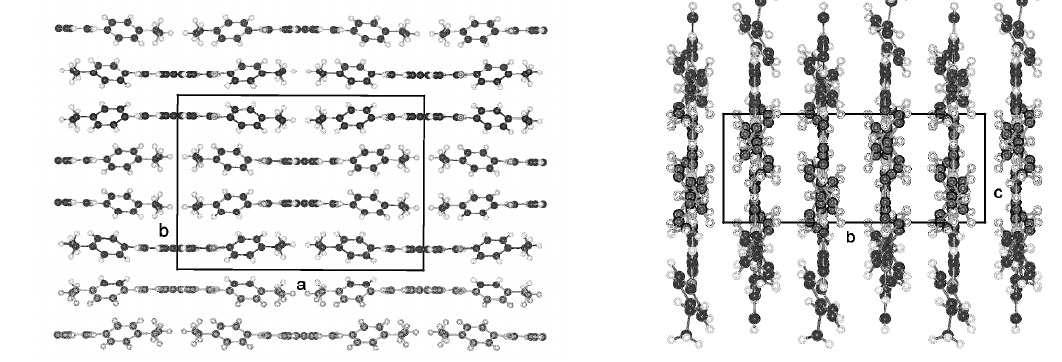
Figure 26. Representation of the packing arrangement of TBAA-2, space group Pbcn, in two projections, on the a,b-plane and down the average molecular axes to demonstrate the string-like arrangements of neighboring molecules. Note the different orientation of the molecules as compared to TBAA-0 (Figure 24) and TBAA-1 (Figure 25).